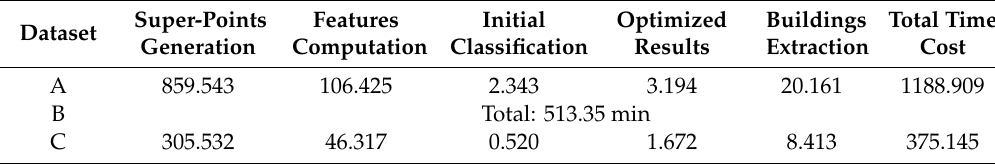
Table 4. Time performance by each stage of the proposed method